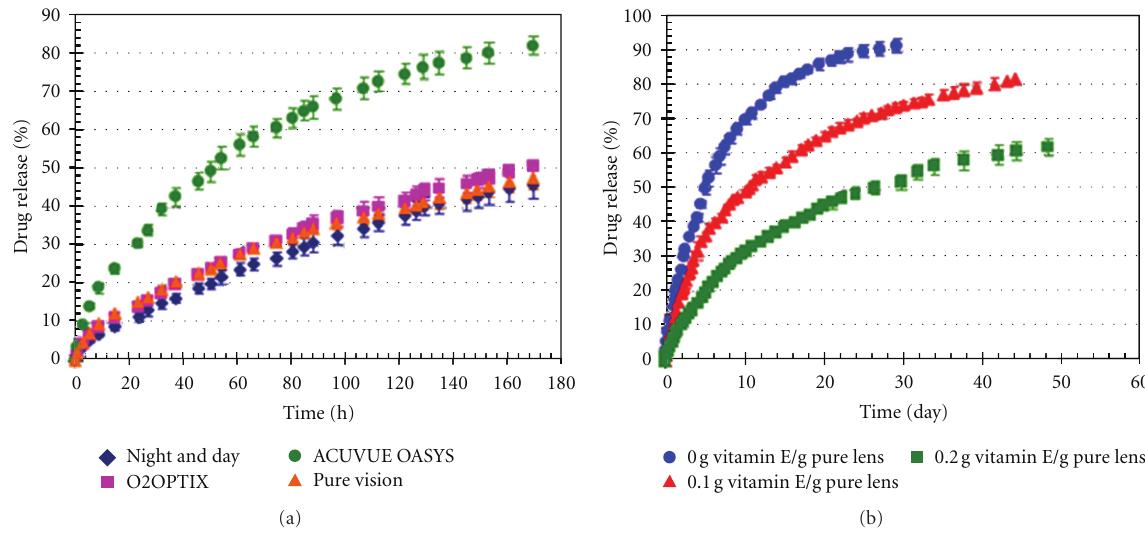
Figure 5: (a) Cumulative CsA release from silicone contact lens, (b) cumulative drug release from Vitamin E loaded ACUVUE OASYS lenses. ∗ Data are plotted as mean ± SD ( n = 3)